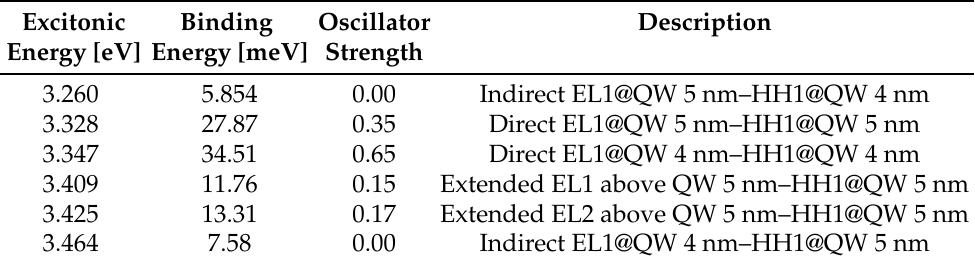
Table 2. Calculated excitonic and binding energy, oscillator strength within 8 k·p self-consistent excitonic model for various type of excitons observed in the structure #1.